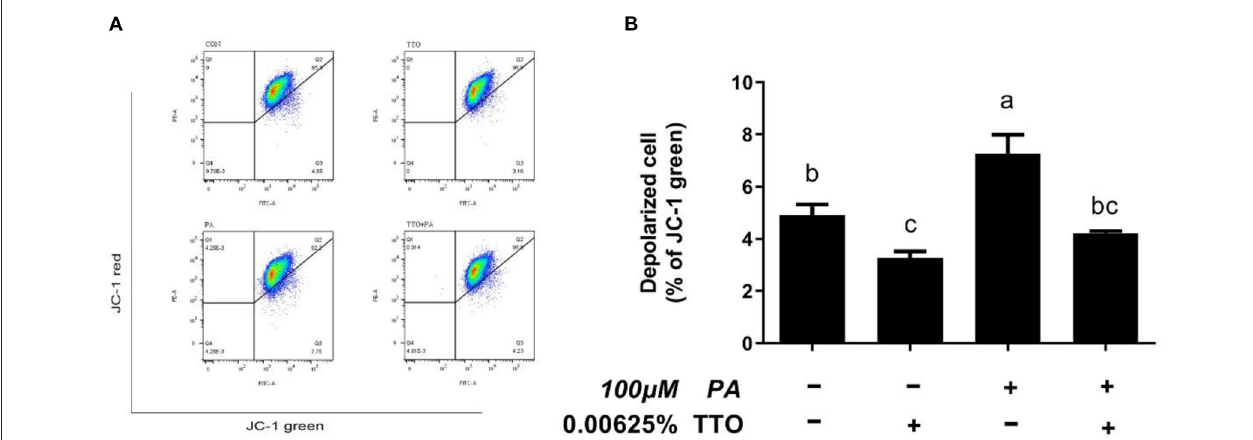
FIGURE 7 | The effect of TTO on mitochondrial membrane potential. (A) Mitochondrial membrane potential in bovine hepatocytes treated with TTO (0.00625%) and/or PA (100 µ M). Mitochondrial membrane potential following the different treatments was measured by staining with JC-1. The fluorescence was detected using flow cytometry. The number of depolarized cells is indicated as a percentage of the total cells. (B) The mitochondrial membrane potential percentages in cultures exposed to TTO or PA. All results are expressed as the mean ± SEM. The letters above the error bars indicate that the difference between groups was significant ( P < 0.05). These data are representative of three independent